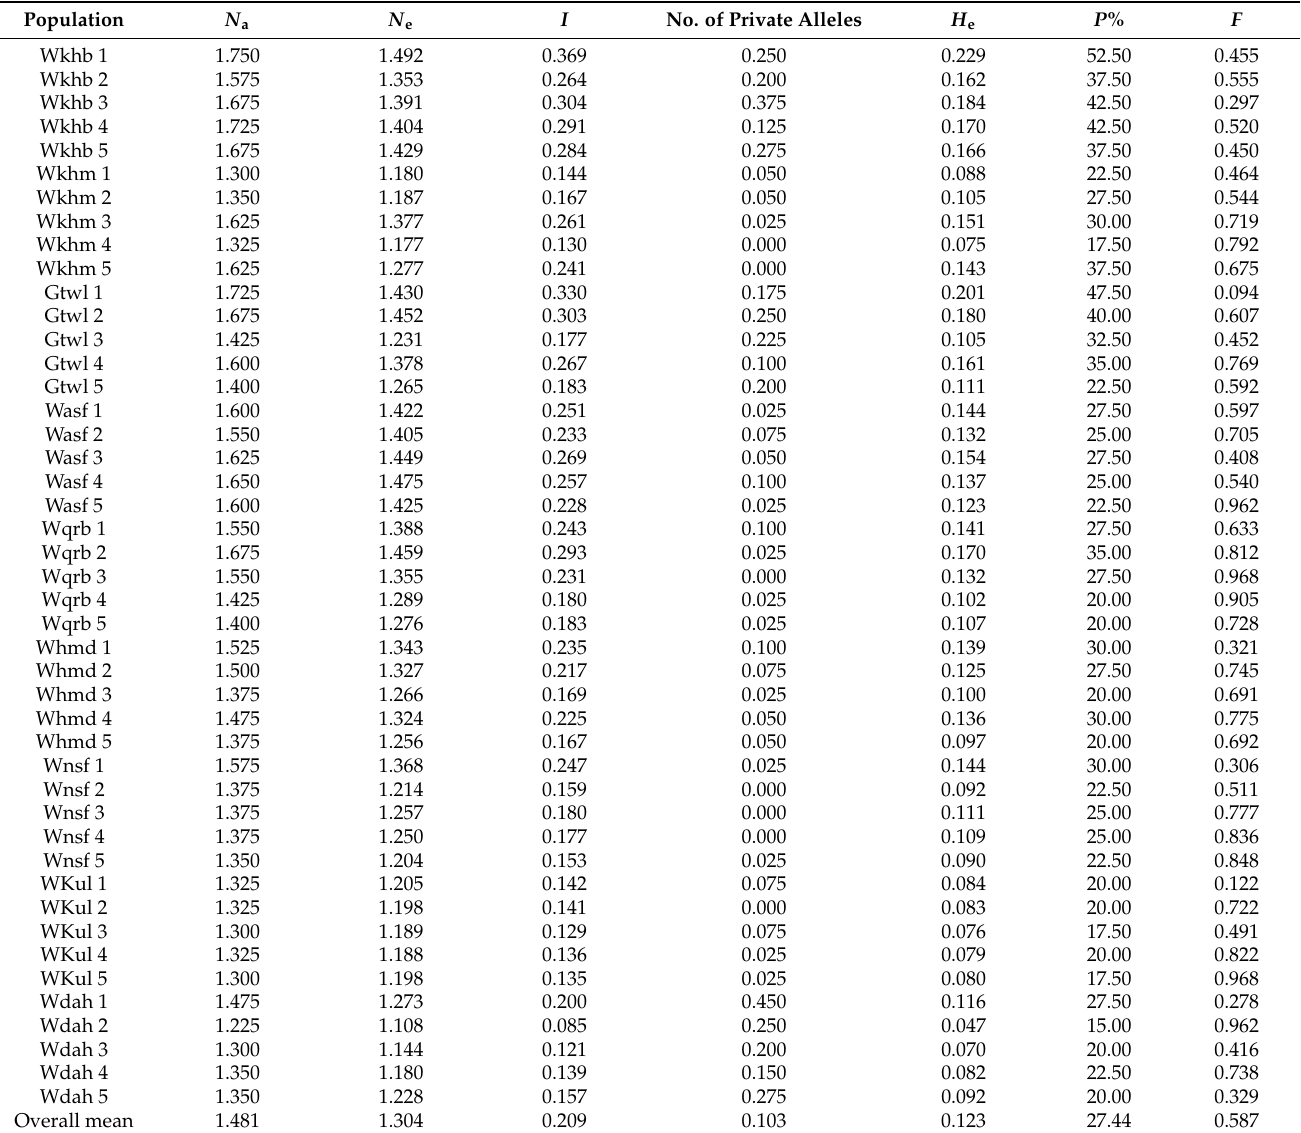
Table 3. The mean values of the of genetic diversity variables across the studied populations of R. epapposum : N a (no. of different alleles), N e (no. of effective alleles), I (Shannon’s